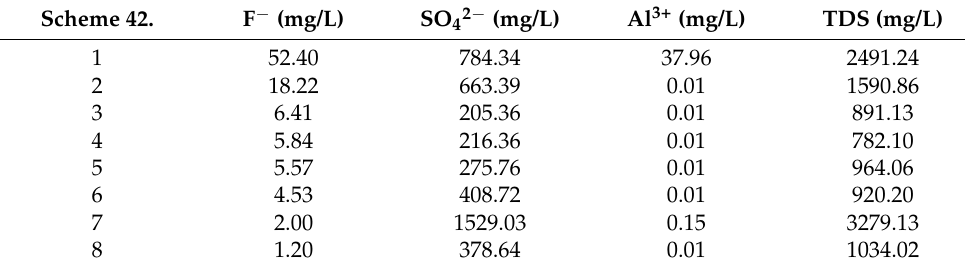
Table 1. Test results of groundwater